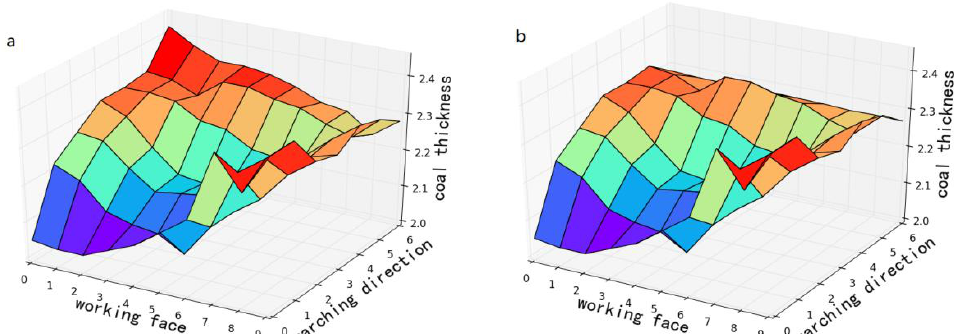
Figure 13. 3D visualization of the coal seam surface obtained from the real experiment: ( a ) Real surface and ( b ) prediction surface.